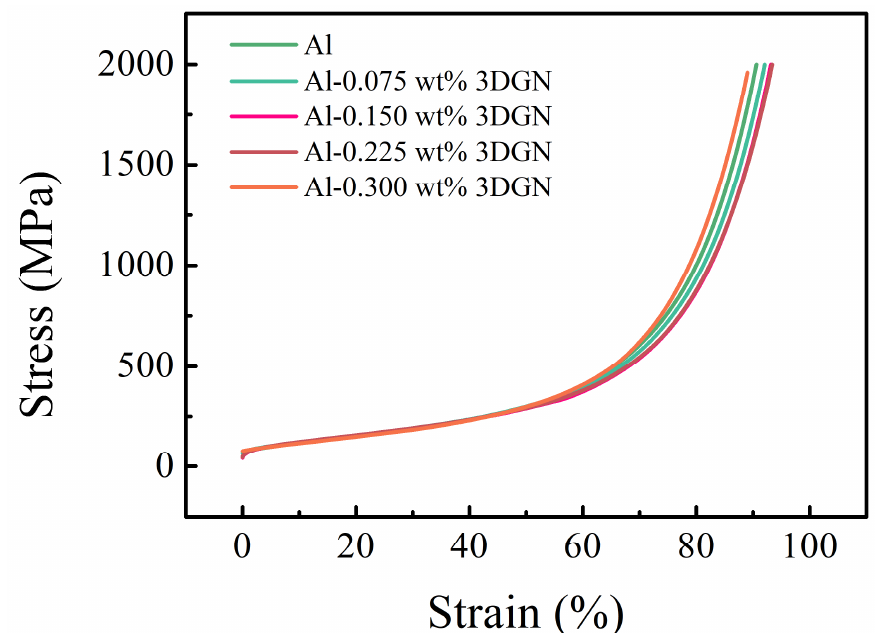
Figure 8. Compressive curves of the bulk 3DGN/Al composites with different 3DGN contents.